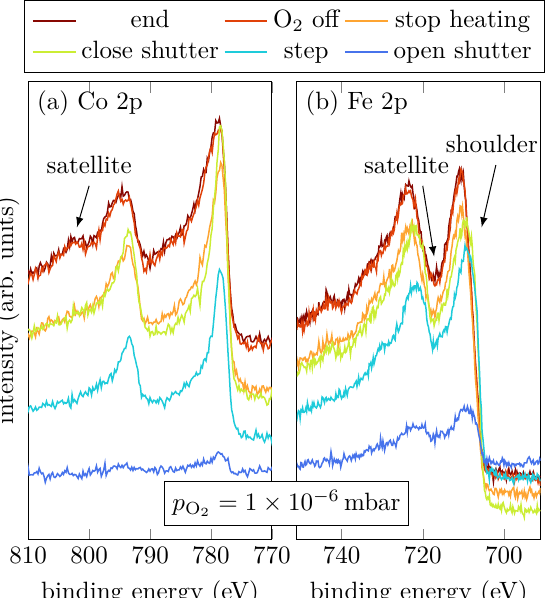
Figure 4. HAXPES spectra of sample B for characteristic events, as displayed, of the Fe 2p and Co 2p